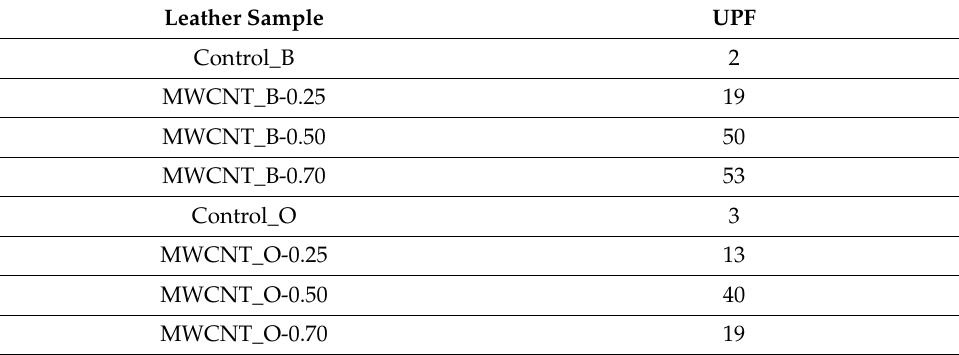
Table 3. UPF of leather surfaces treated with multi-walled carbon nanotubes. Leather